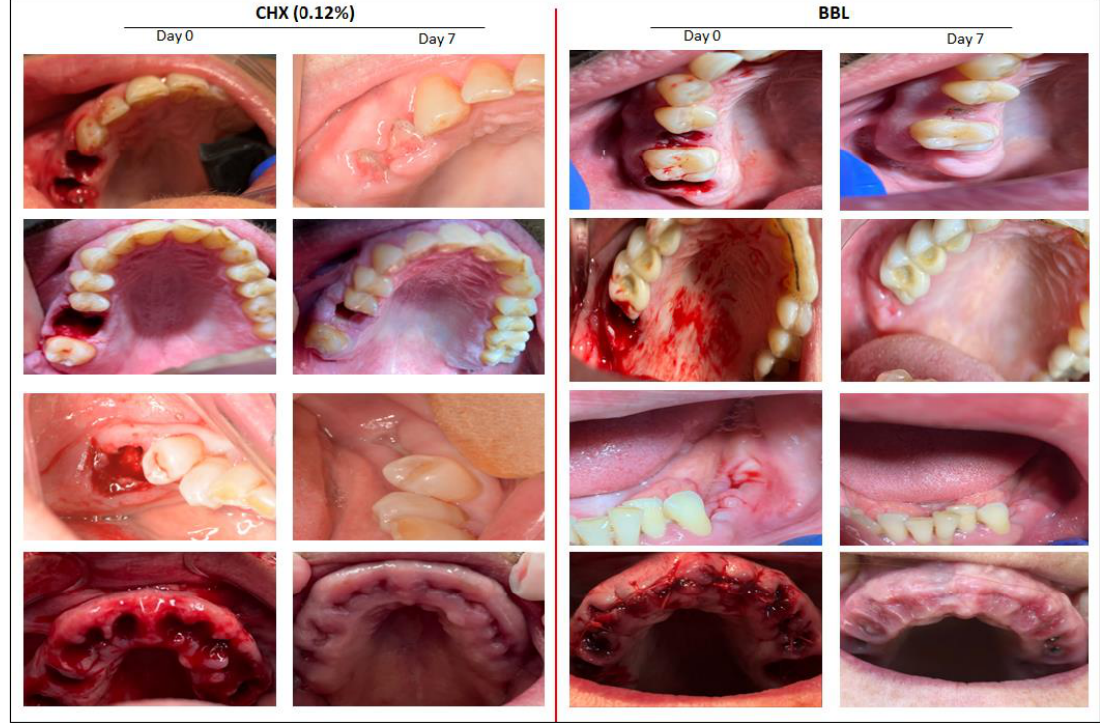
Figure 2. Representative images for patients at the surgery day 0 and after 7 days using CHX or BBL mouthwash. Notable wound healing improvements were detected in patients who used BBL mouthwash. Table 2. The early wound healing index (EHI) scores were determined as described by Landry et al. 1988. EHI